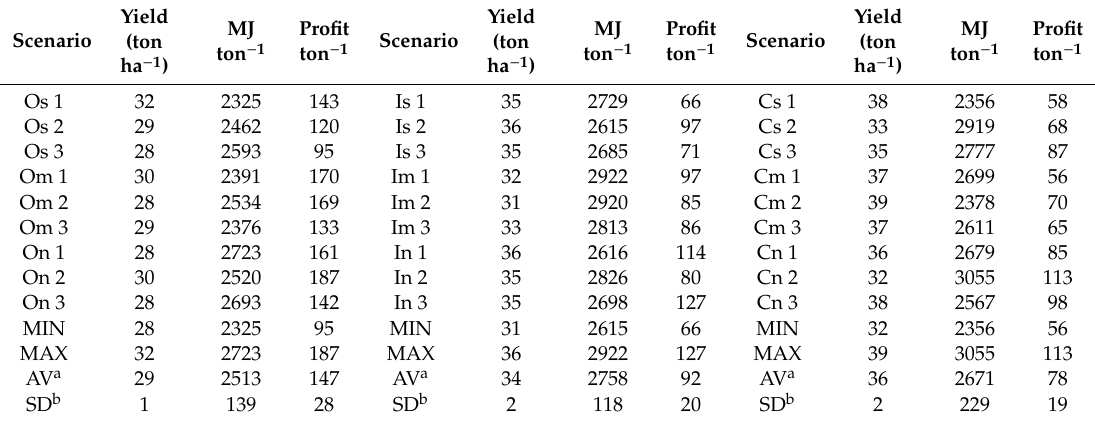
Table 9. Results of sensitivity